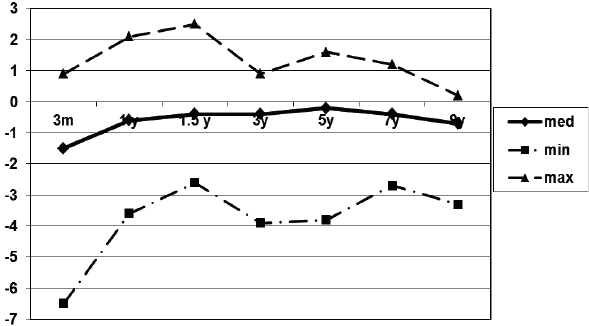
Fig. 3. Body weight (SDS) in comparison with the standard Czech population (0 level) in 3 months, 1, year, 1.5 years, 3, 5, 7 and 9